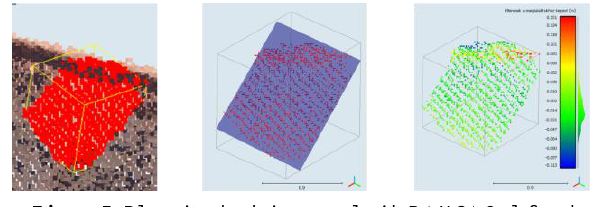
Figure 5 . Planarity check in a voxel with RANSAC, left red points in the voxel, found plane in the middle, inliers, and outliers on the right.